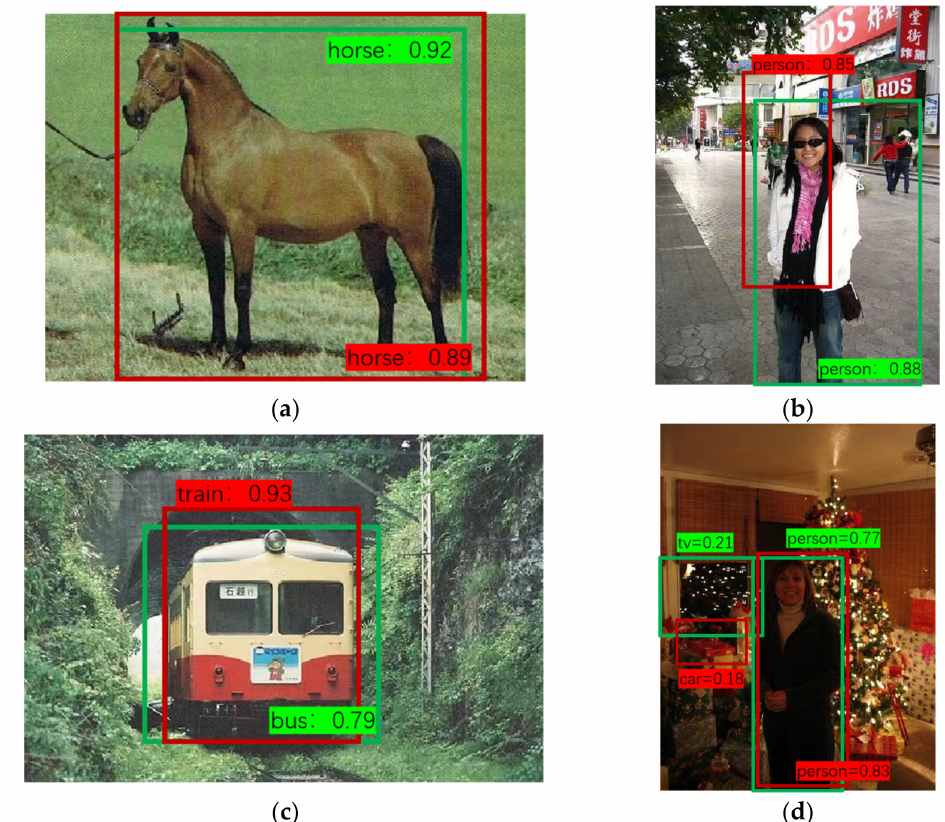
Figure 3. Example images for localization stability and classification stability analysis. ( a ) Example of high localization stability and high classification stability. ( b ) Example of low localization stability but high classification stability. ( c ) Example of high localization stability but low classification stability. ( d ) Example of low localization stability and low classification